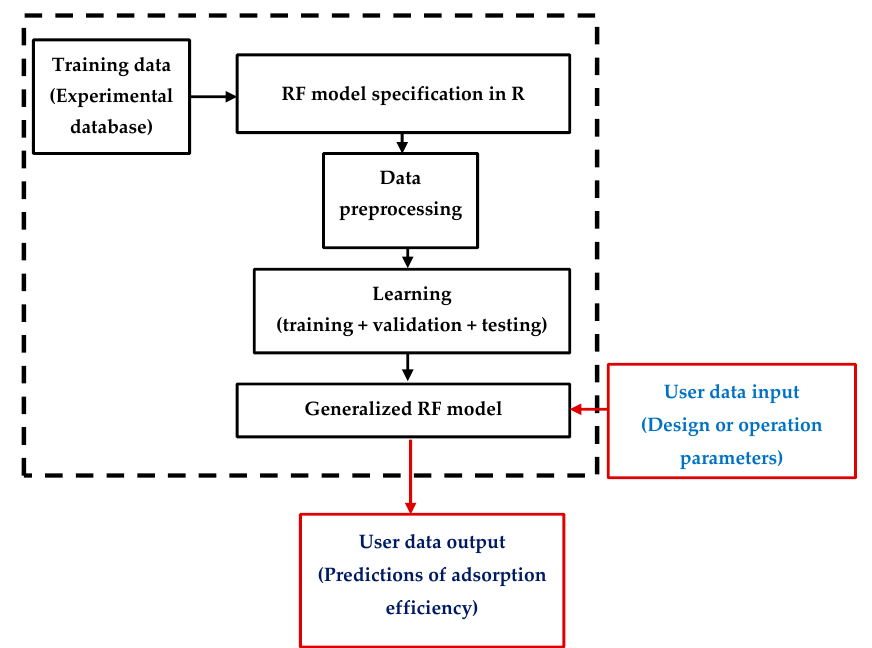
Figure 5. Presentation of the automated prediction methodology by using the current ML model.